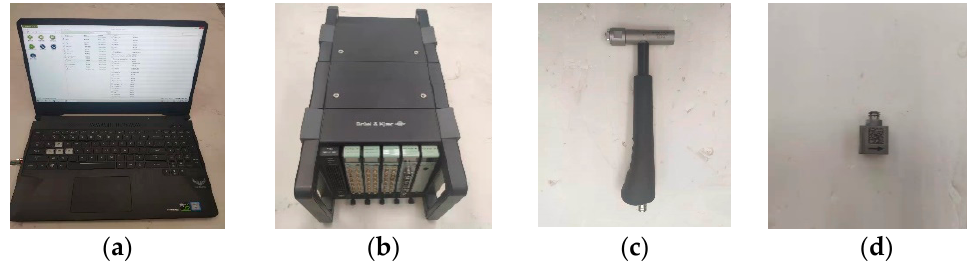
Figure 7. ( a ) Computer, ( b ) B&K3660C analyzer, ( c ) Impact hammer, and ( d ) Accelerometer.